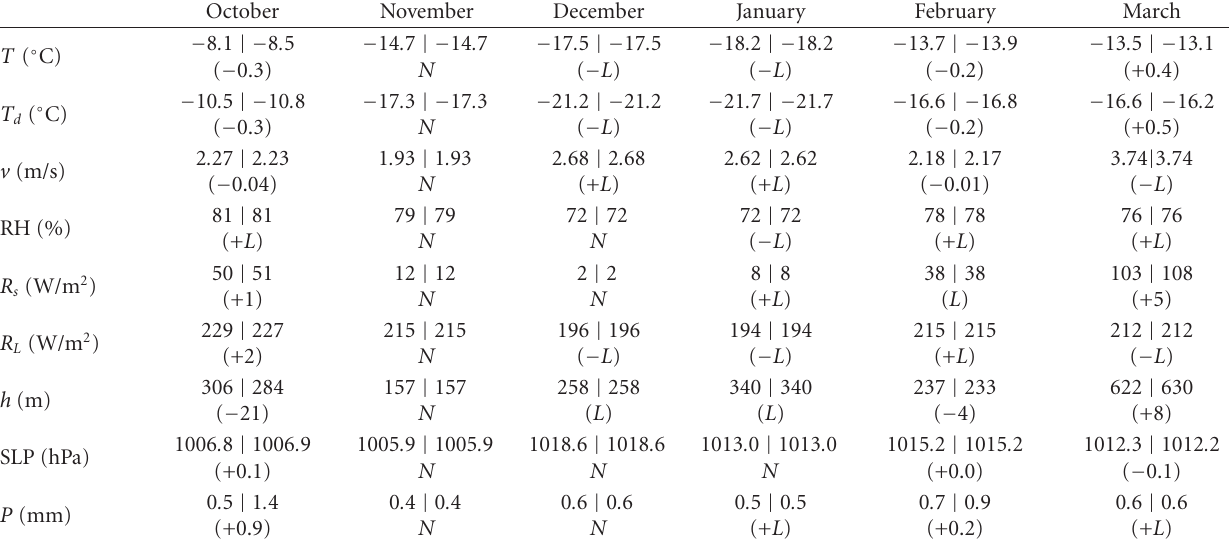
Figure 3: Di ff erence REF-LSF of monthly averaged 24 h-average PM 2 . 5 concentrations (color) from October to March. The hashed shading indicates significant (95% or higher confidence level) di ff erences. The red polygon indicates the boundaries of the Fairbanks nonattainment area. Table 3: Monthly average of near-surface air temperature ( T ), dewpoint temperature ( T d ), wind speed ( v ), relative humidity (RH) and downward shortwave radiation ( R s ), ABL-height ( h ) and sea-level pressure (SLP), and precipitation ( P ) in the nonattainment area as obtained by REF (first value) and LSF (second value). Relative di ff erences are in brackets. The letters L and N represent changes < 0.001 and no change,